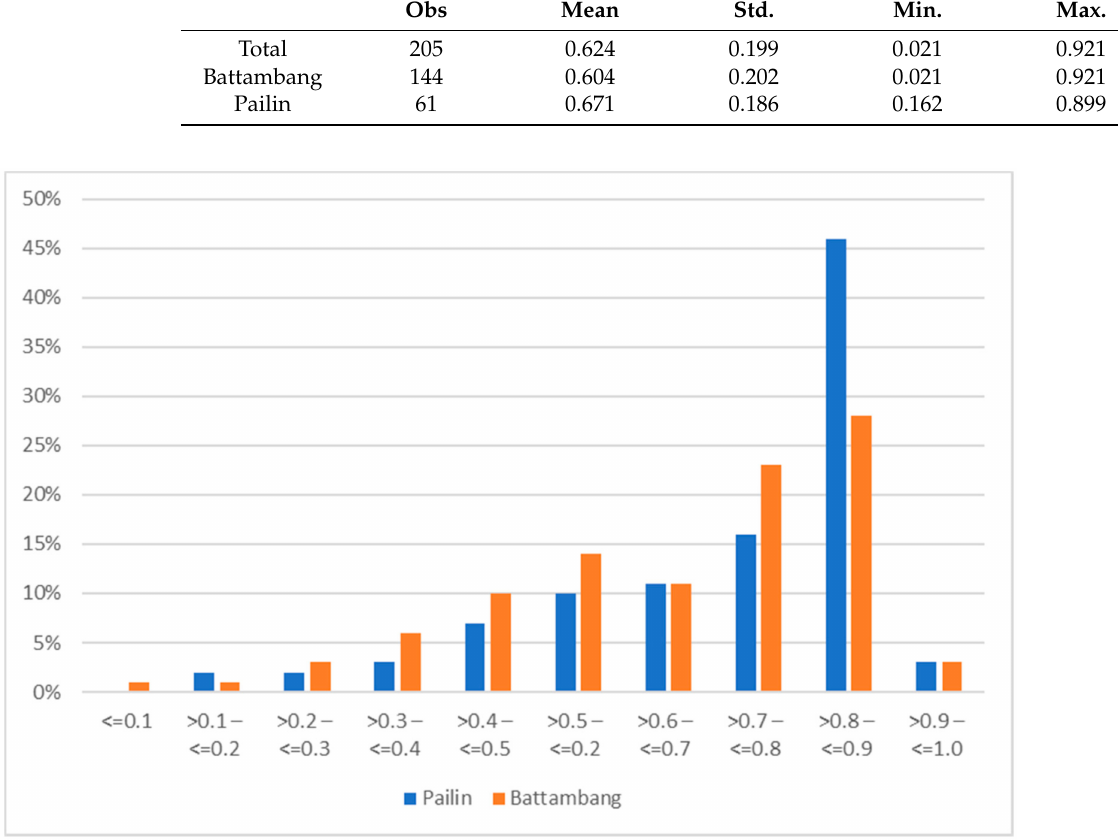
Figure 2. Frequency distribution of technical